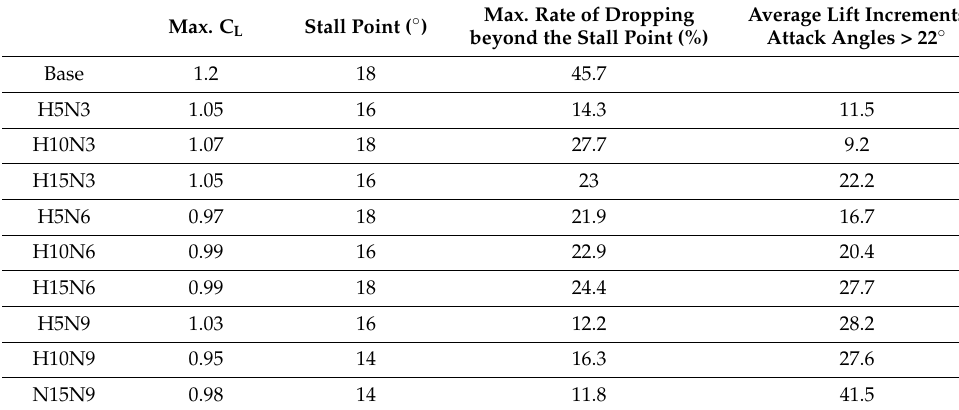
Table 3. Summaries of hydrodynamic parameters.